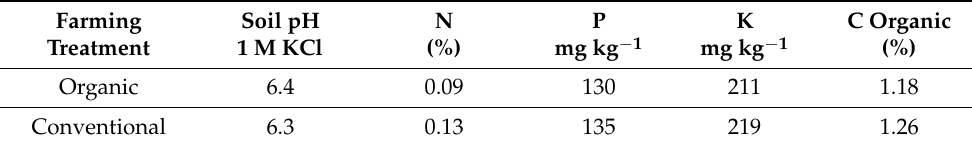
Table 1. Soil characteristics prior to establishing a spring wheat experiment (2017).